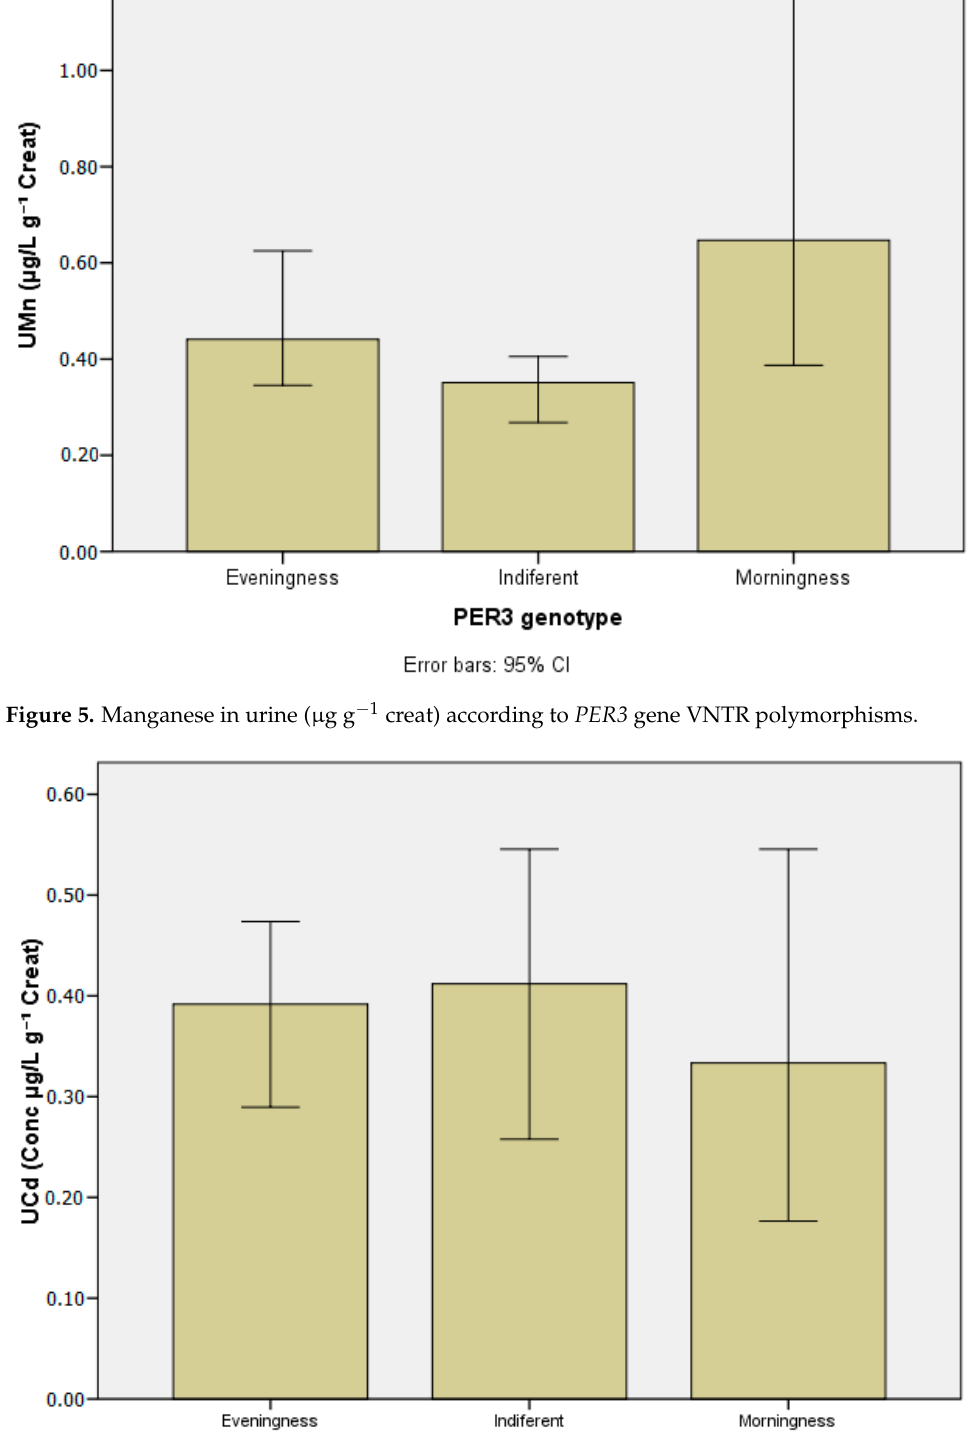
Figure 4. Manganese in blood ( μ g/L) according to PER3 gene VNTR polymorphisms.